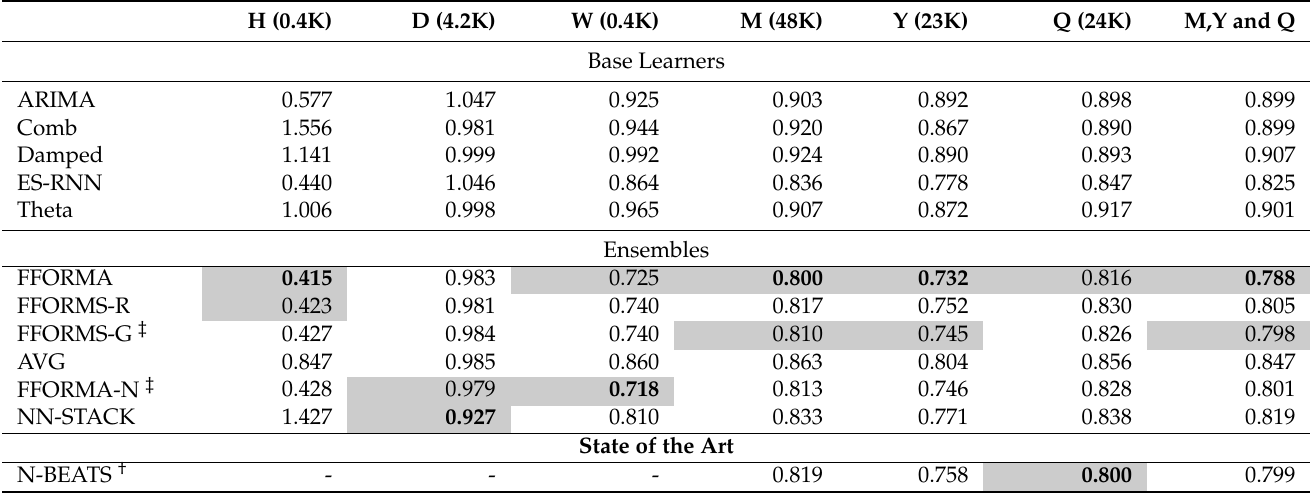
Table 3. Average OWA errors on the M4 test set, where lower values are